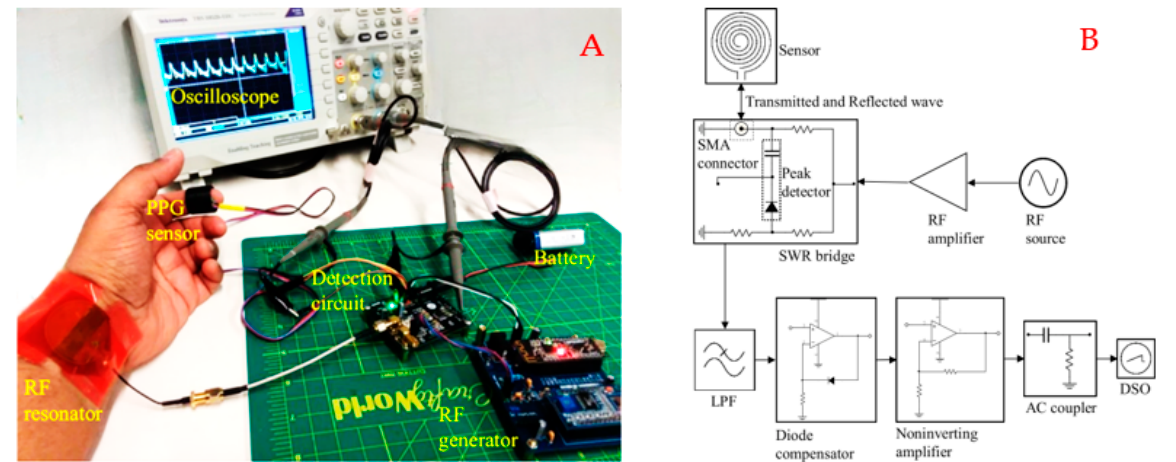
Figure 5. ( A ) Experimental setup for radial pulse detection, ( B ) block diagram of the recording system (contains the RF transmitter and the demodulator circuits) based on modular detection circuits with a benchtop oscilloscope to record the demodulated signal.